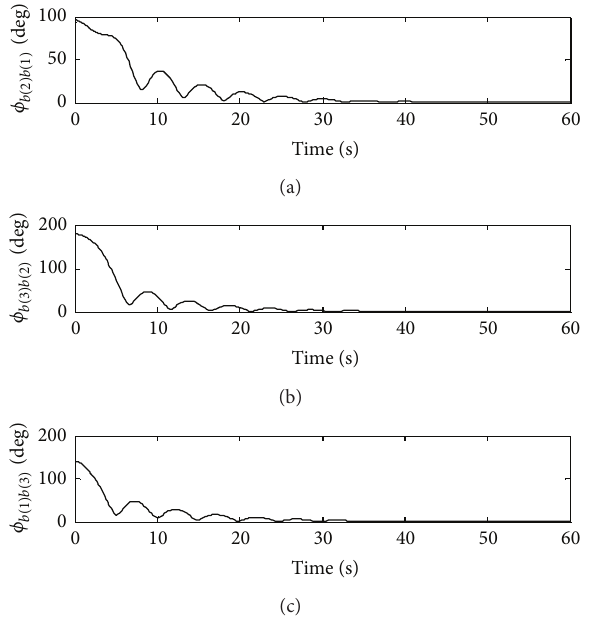
Figure 12: Relative Euler angle between spacecrafts; Theorem 6.